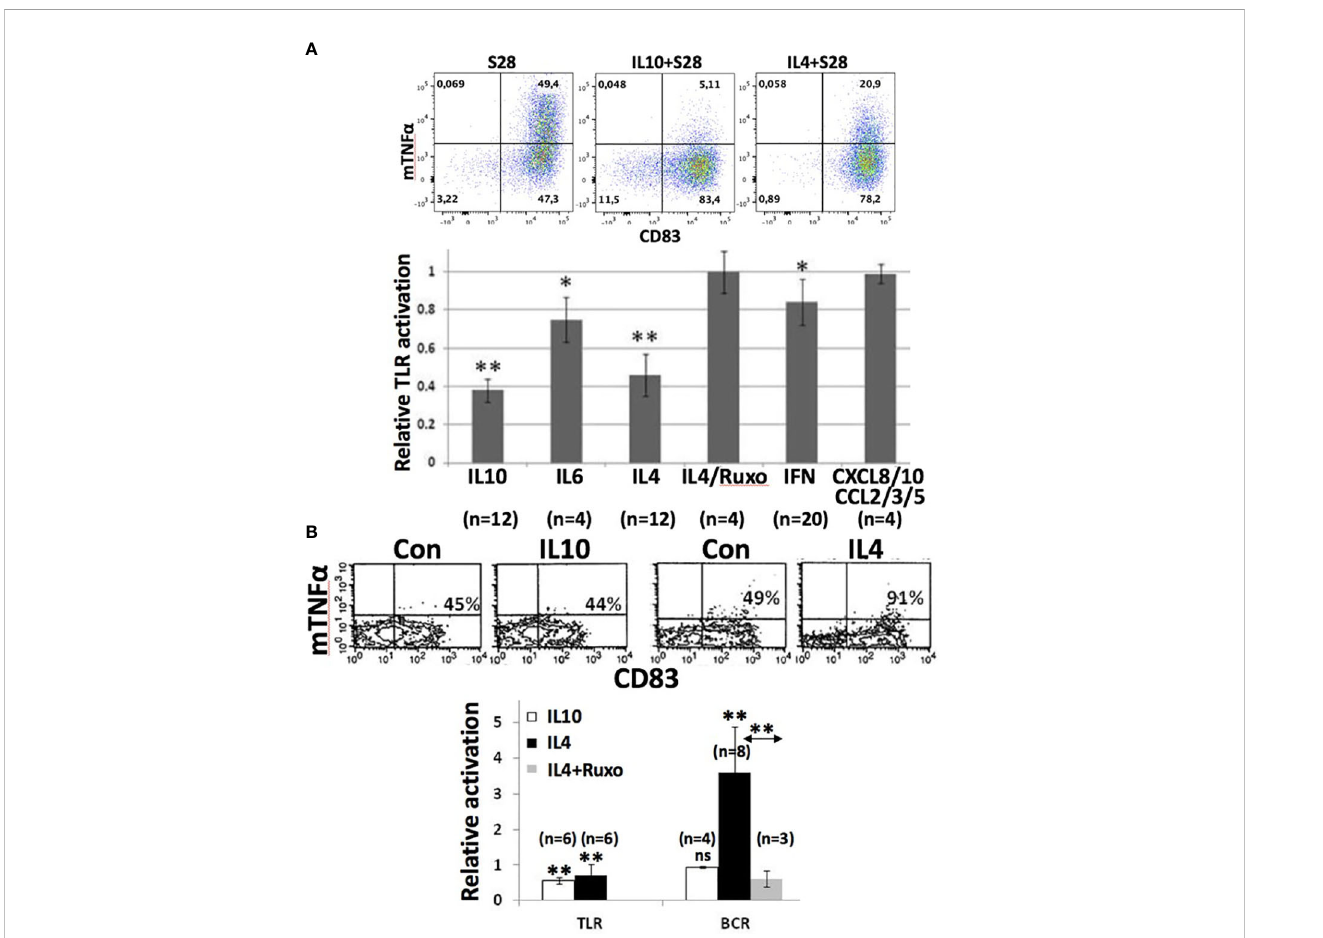
FIGURE 4 Effect of cytokines and chemokines on TLR- and BCR-signaling in CLL cells in vitro . CLL cells were cultured for 48 h in the presence or absence of pre-optimized concentrations of IL-10 (10 ng/ml), IL-6 (100 ng/ml), IL-4 (40 ng/ml), IFN b (500 U/ml), or a mixture of CXCL8, CXCL10, CCL2, CCL3, CCL5 (each at 20 ng/ml) with or without ruxolitinib. The cells were then stimulated with resiquimod (A) or anti-IgM antibodies (B) and membrane TNF a and CD83 expression measured 4 h later by fl ow cytometry. Examples are shown above the summary graphs. Numbers in the histograms represent percentages of mTNF a + CD83 + cells for TLR-activation and CD83 + cells for BCR-crosslinking. Relative TLR- or BCR-activation were determined for each sample by dividing the percentage of mTNF a + CD83 + cells or CD83 + cells, respectively, following co-culture with cytokines by the percentages obtained in control cultures. BCR-activation with IL4 plus ruxolitinib is reported relative to the result with IL4. The average and standard error of relative TLR- or BCR-activation for the indicated numbers of patient samples are shown in the graphs. *, p<.05; **,